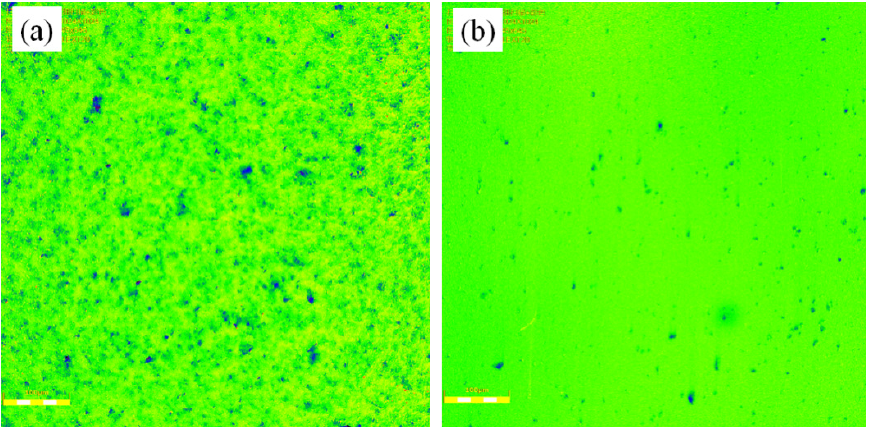
Figure 12. The morphology images of the polished workpiece surface: ( a ) before and ( b ) after being polished.